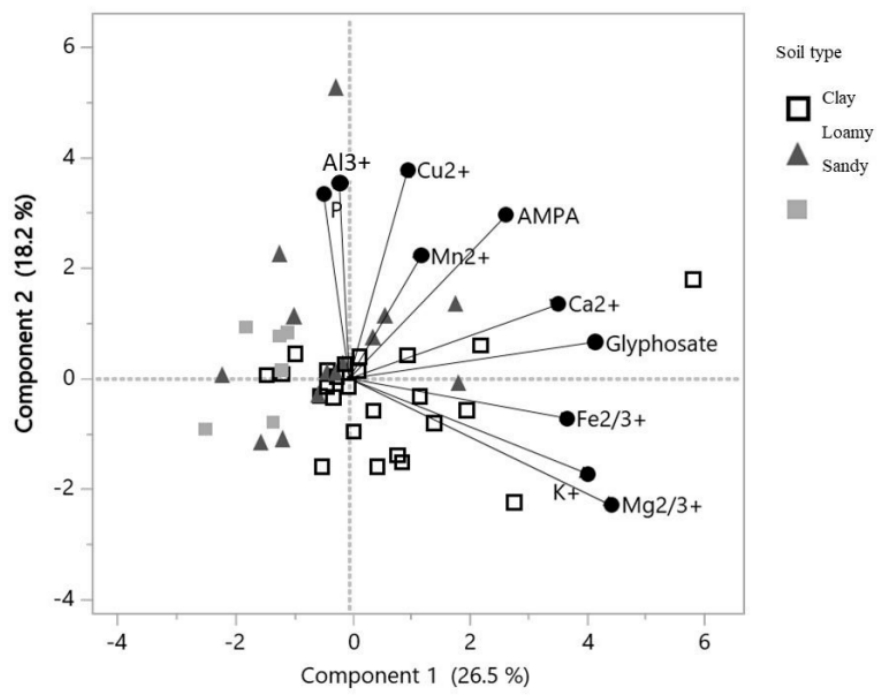
Figure 5. Graphic representation of the PCA based on components 1 and 2, incorporating the additional variable of the three major textural classes (clay, loamy and sandy), according to the three soybean crop management systems (RR, IP and OF). Table 4. Partial contribution of variables as %, representing the composition of soils derived from the PCA, according to the 5 axes chosen and representing 80.45% of total inertia.